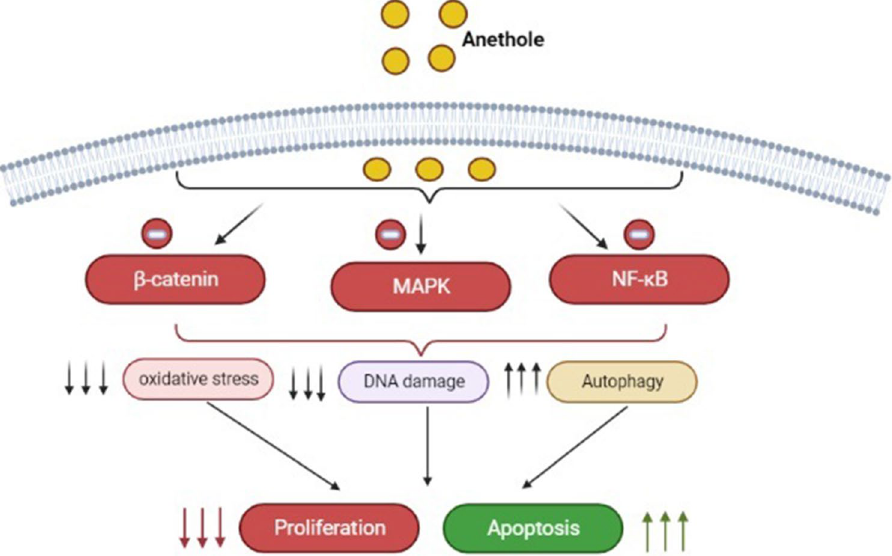
Figure 8. Schematic diagram showing the hypothesized mechanism of anethole-induced selective killing of human oral cancer Ca9-22 cells. In Ca9-22 treated with anethole, enhanced activation of apoptosis pathways against the inhibition of proliferative